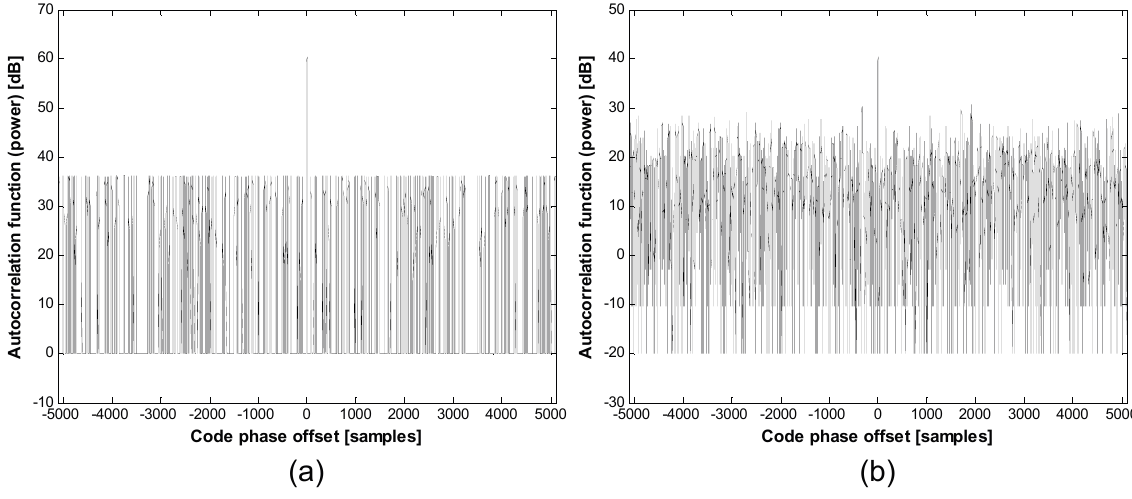
Figure 2. Partial correlation effect on the power: ( a ) duty ratio of 1.0; ( b ) duty ratio of 0.1.